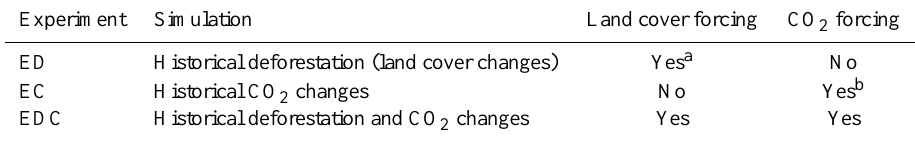
Table 1. Simulation